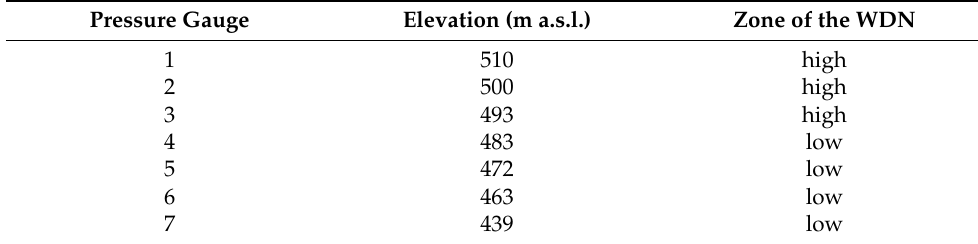
Table 1. Elevation of the installation sites of the pressure gauges. Pressure Gauge Elevation (m